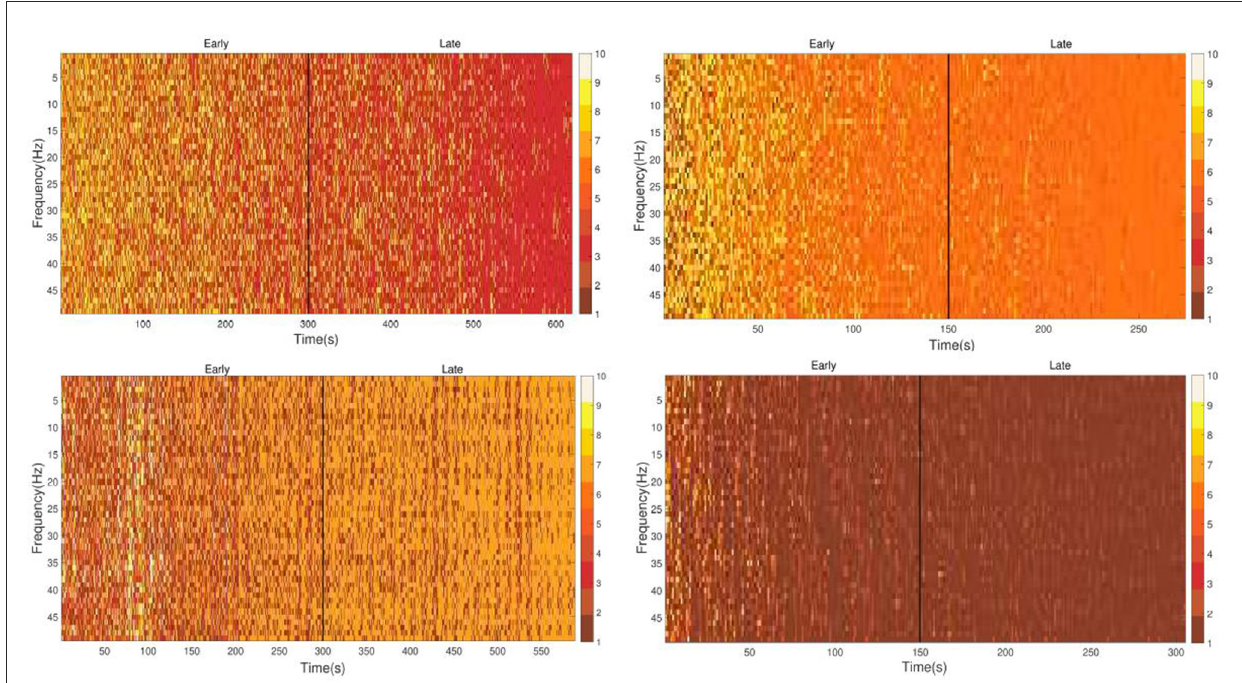
FIGURE10 Comparison of representative patterns of TFT-epochs/cognitive subprocesses from physiological (EEG) measure and qualitative (mental workload) assessment. Top: subject trained with low level of task abstraction from VE. (Left) First session of training and (right) execution of trained task. In the mental workload assessment, the subject obtained the first session of training = 87.0 and when executing in RE the trained task = 84.3. Bottom: subject trained with high level of task abstraction from VE. (left) First session of training and (right) execution from RE of the trained task. In the mental workload assessment, the subject obtained the first session of training = 66.7 and when executing in RE the trained task = 65.3. Each color on the bar plots represents a cluster by HCA, which is assumed to represent a different cognitive subprocess.